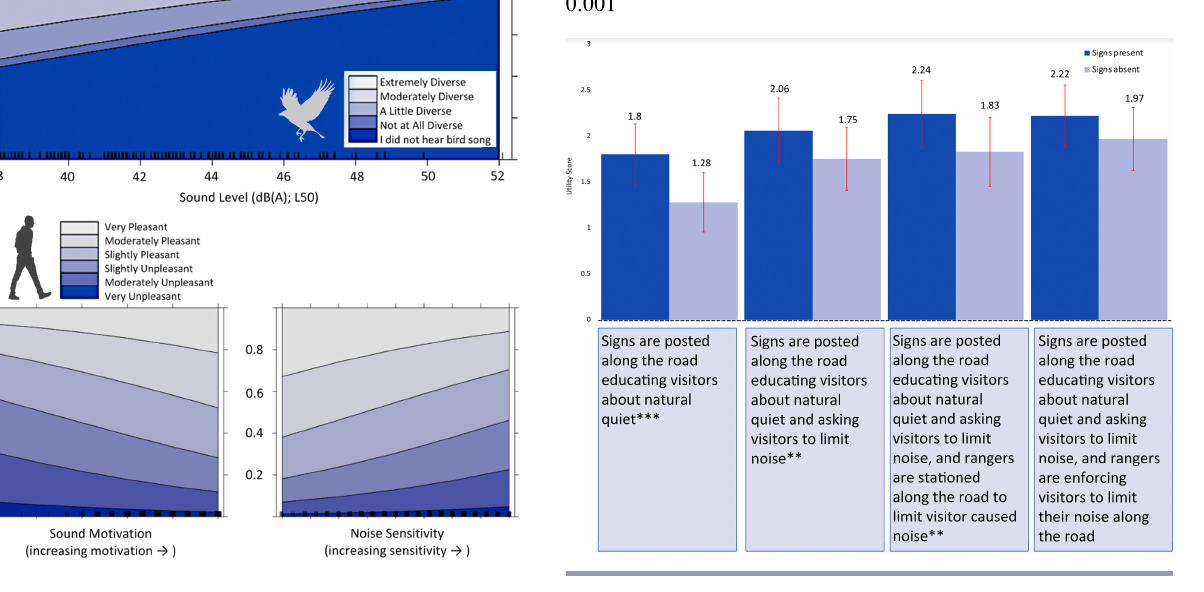
Fig. 2 . Background sound levels and visitor traits affect soundscape experiences. (a.) Probability of visitor-reported bird chorus diversity ratings in response to sound level (L50 dB(A)). (b.) Probability of visitor-reported soundscape pleasantness ratings in relation to sound motivation and noise sensitivity